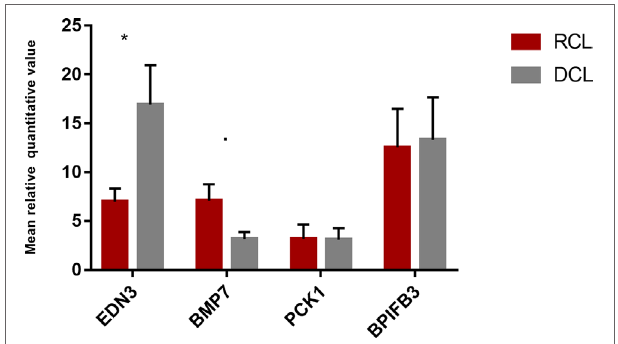
FIGURE 6 | Expression analysis of candidate genes. The quantitative real- time polymerase chain reaction (qPCR) analysis of four genes ( EDN3 , BMP7 , PCK1 , and BPIFB3 ) in the ovary tissue of dark comb and red comb chickens. The error bars indicate the standard error of the mean. * p < 0.05, · p <